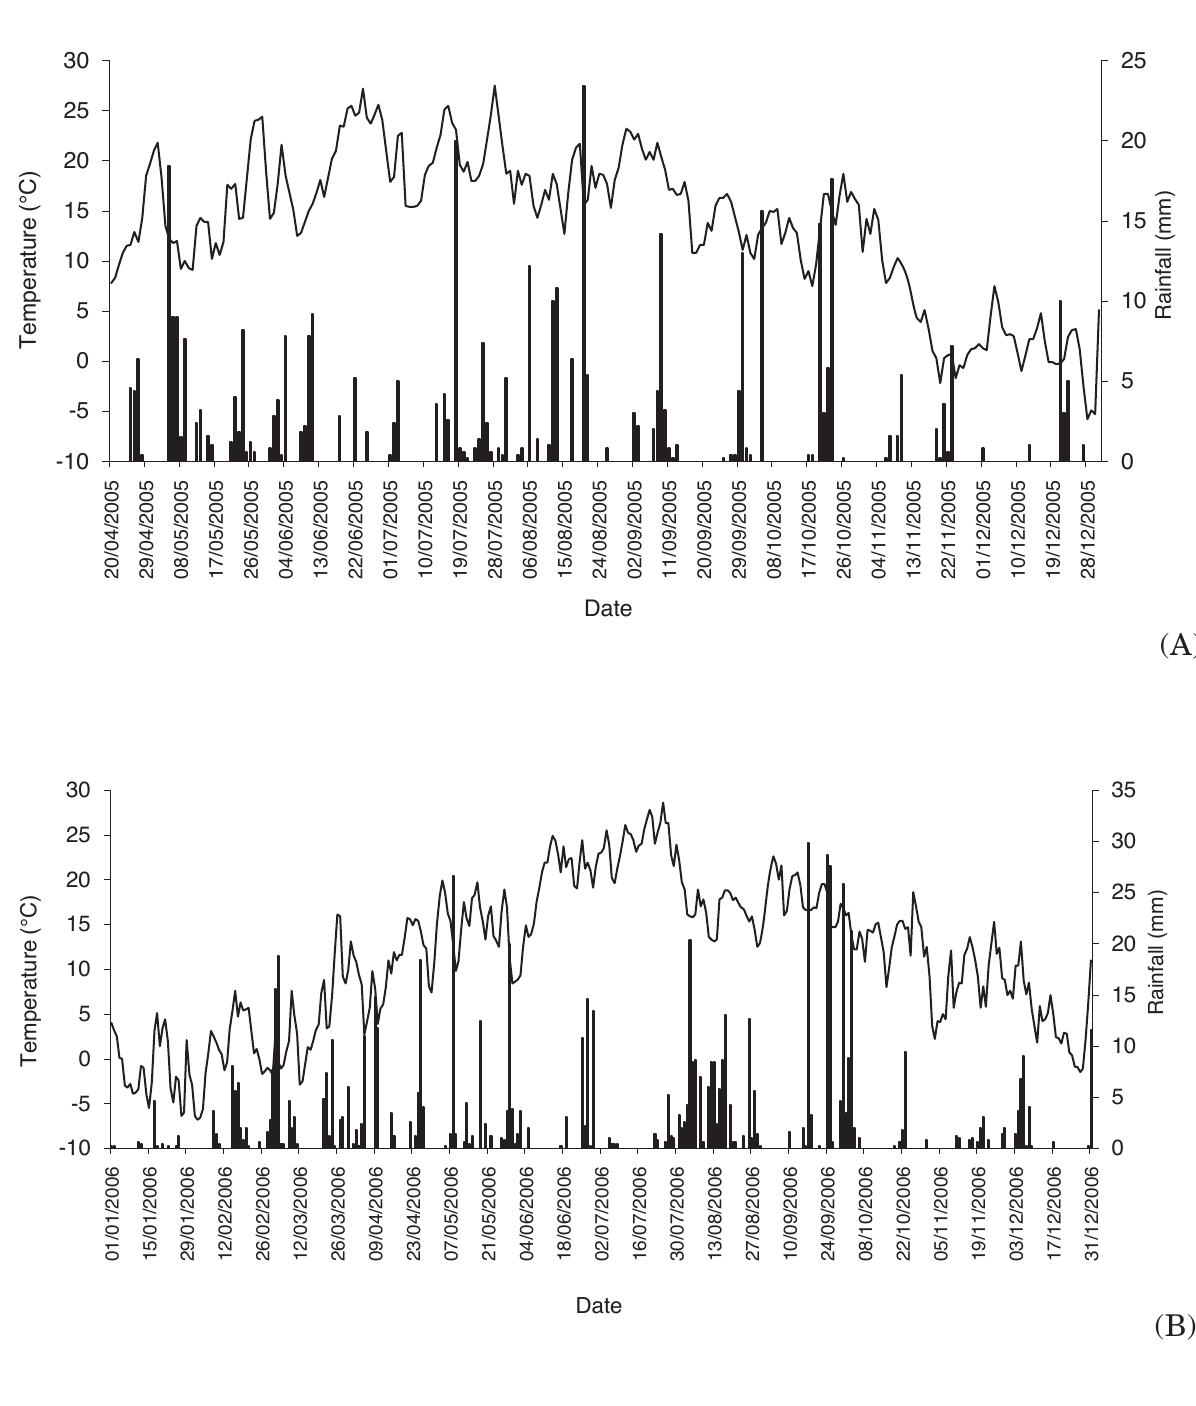
Fig 2. Temperature (line) and rainfall (columns) between 1 April and 31 December 2005 (A), and between 1 January and 31 December 2006